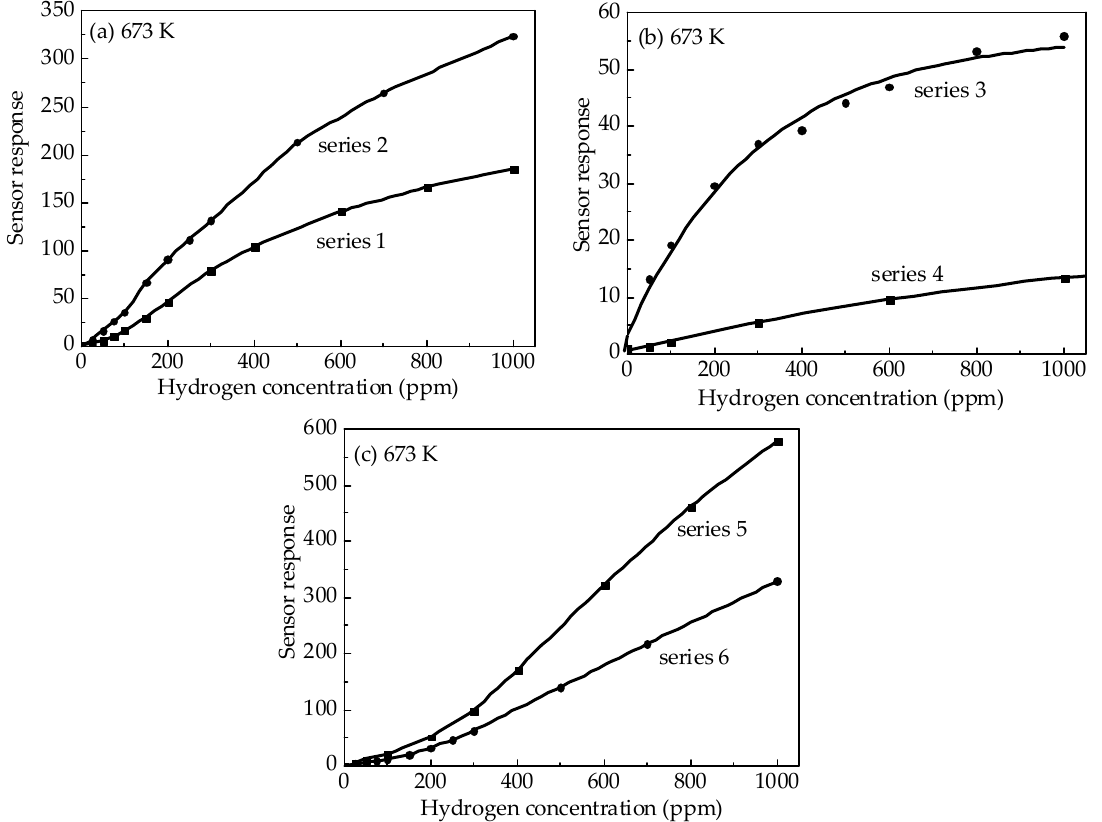
Figure 10. ( a )–( c ) Concentration dependencies of the response of the sensors with various additives. Figure 10. ( a – c ) Concentration dependencies of the response of the sensors with various